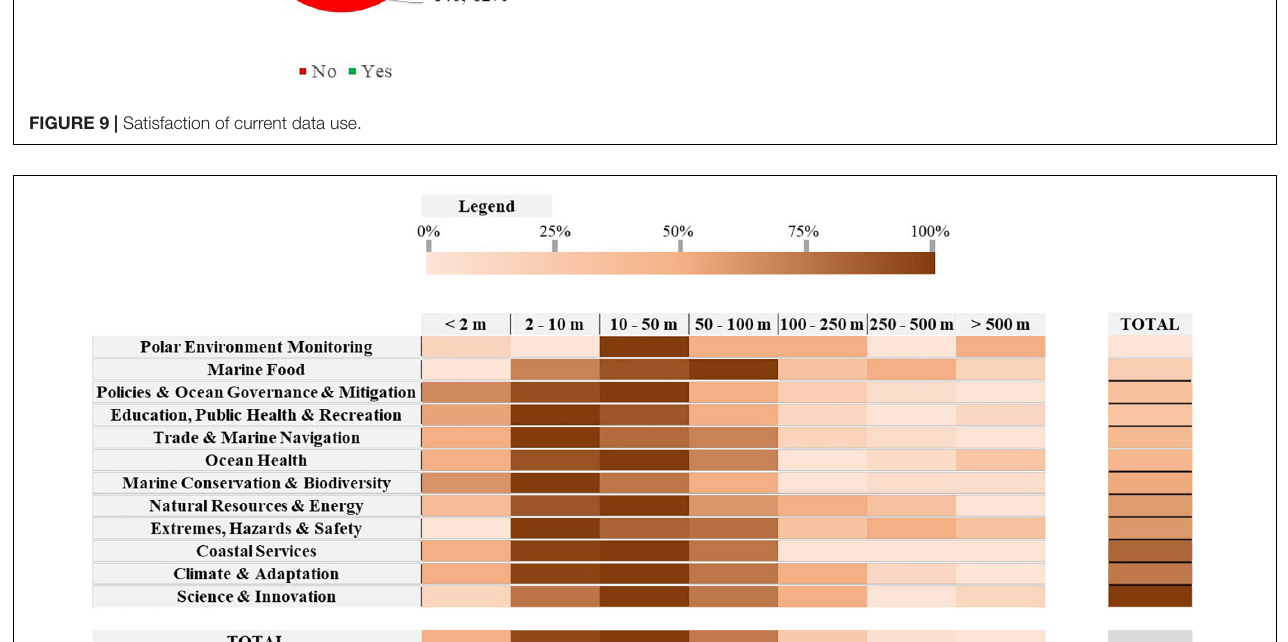
FIGURE 10 | Resolution ranges required by users per market segments. The shading indicates the percentage of the 176 respondents who selected the box (legend at the top).